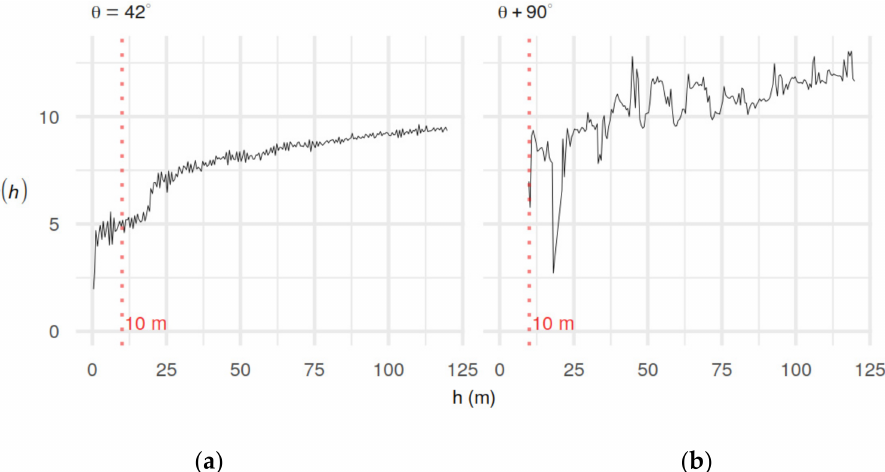
Figure 4. Directional fine-scale experimental variograms for visible and near infrared (VNIR) pre- dicted moisture content (MC %) (lag = 0.5 m, cutoff = 125 m). Anisotropy is calculated along (bearing from north θ ◦ ) ( a ) and across ( θ ◦ + 90 ◦ ) line-scanning direction ( b